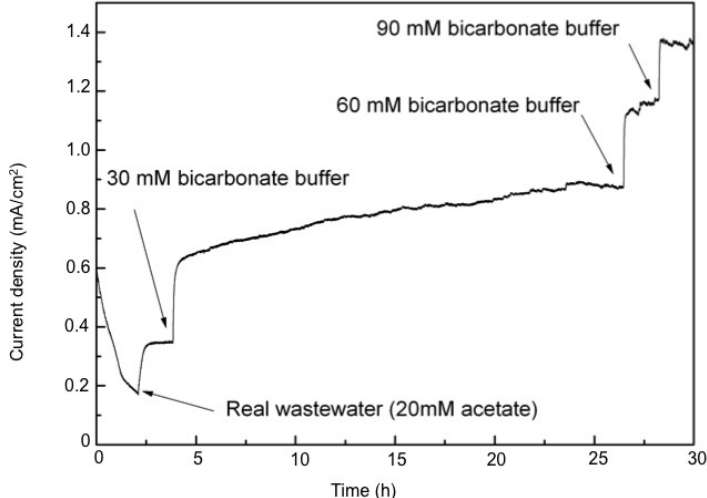
Figure 4. Electric current measured in MEC system when real water matrix is used as fuel (anode at 0.0 V vs. a 3.5 M Ag/AgCl reference electrode). Water matrix is supplemented with 20 mM